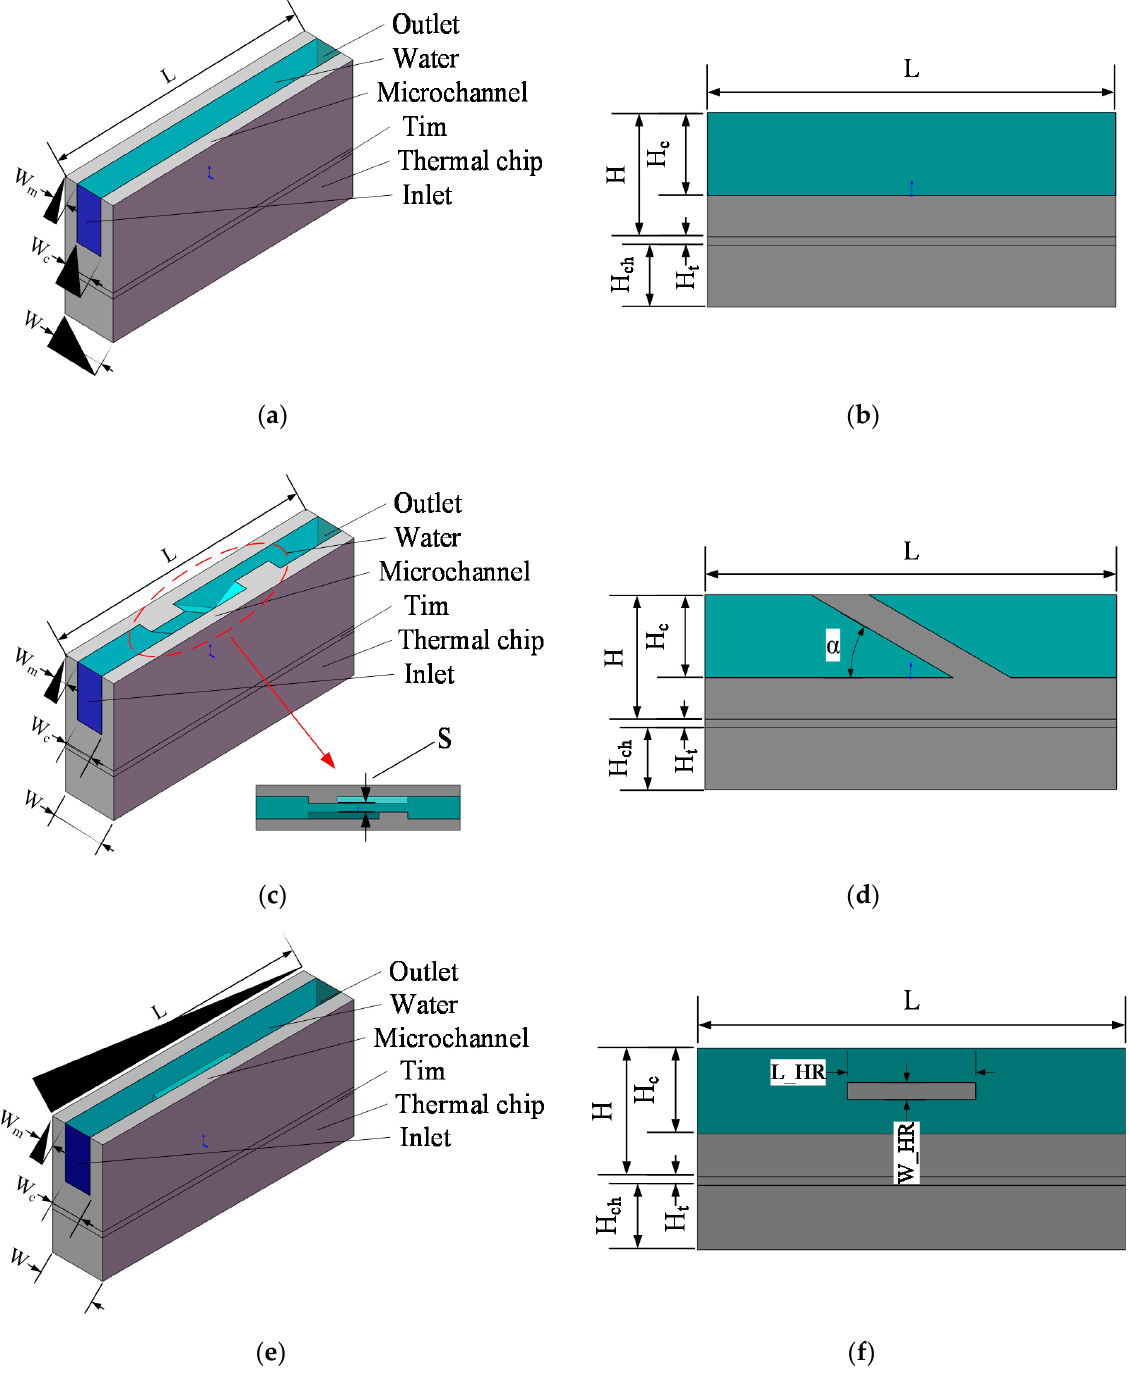
Figure 3. The unit models ( a , c , e ) and cross-sections ( b , d , f ) in the micro-channel heat sink: ( a , b ) MC-R; ( c , d ) MC-CR; ( e , f ) MC-HR.